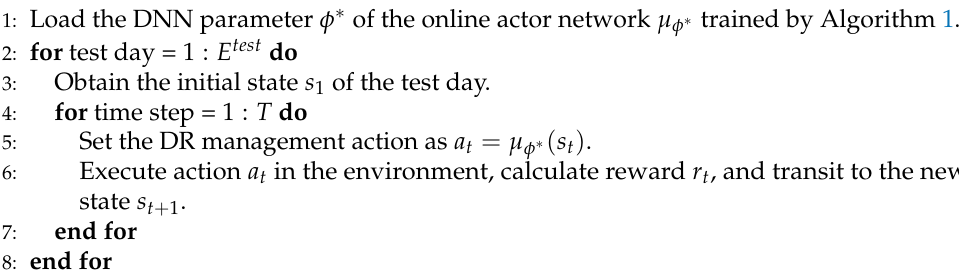
Algorithm 2 TD3-based DR management